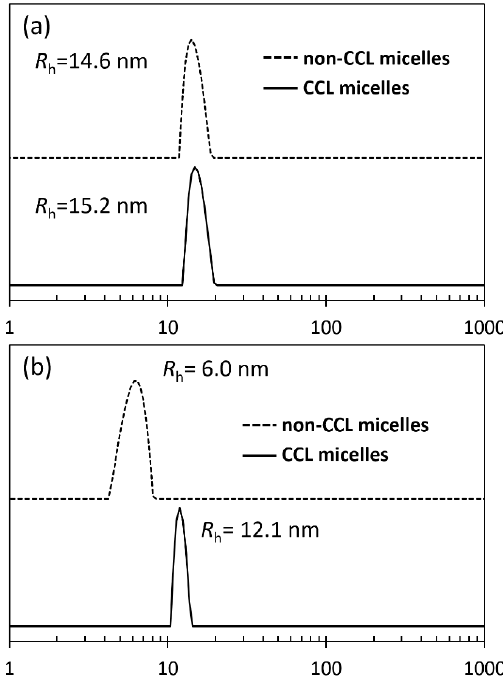
Figure 4. DLS charts of PEG-P(Asp-nonyl-chal-C 8 ) micelles (nonyl = 7.0, chal-C 8 = 8.6) before and after photo irradiation ( a ) in normal saline and ( b ) in methanol containing 0.1 M LiClO 4 .